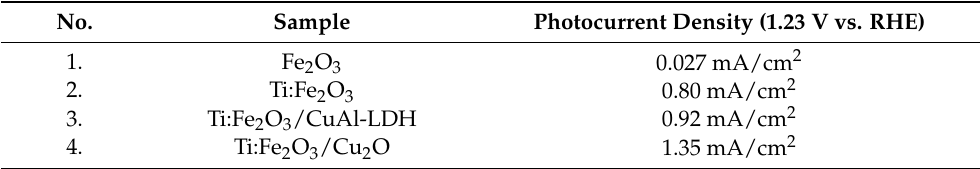
Table 1. Photocurrent density of Fe 2 O 3 , Ti:Fe 2 O 3 , Ti:Fe 2 O 3 /CuAl-LDH, and Ti:Fe 2 O 3 /Cu 2 O. No.